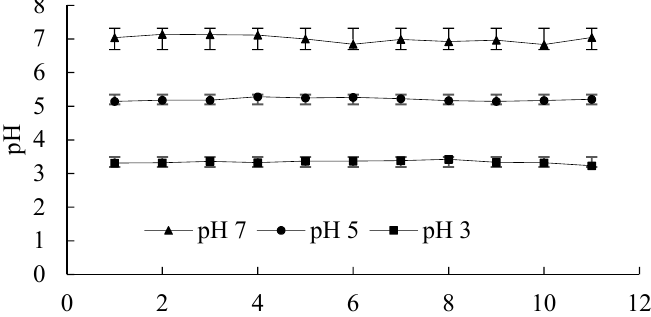
Figure 4. Adjusted pH values and their standard deviation. (The x-axis means the adsorption points corresponding to the adsorption isotherms).